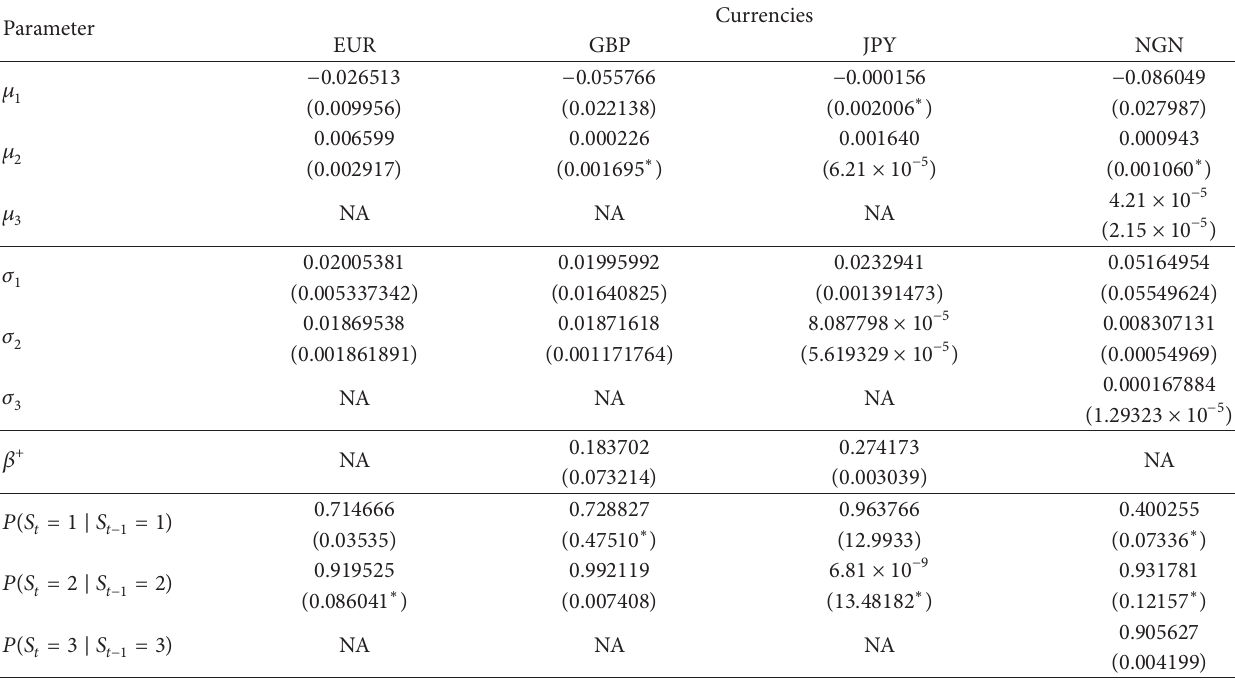
Table 2: Maximum likelihood estimates for selected